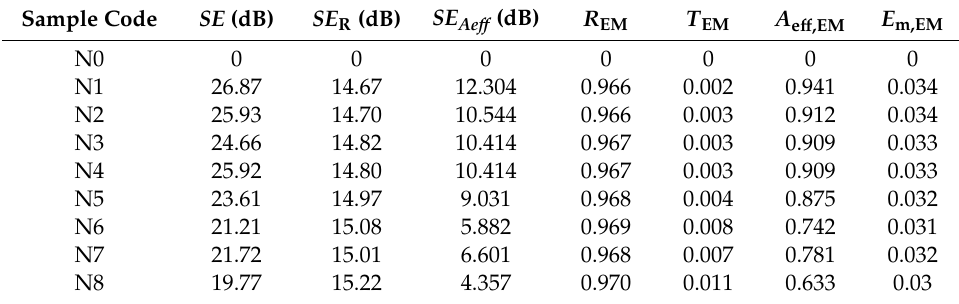
Table 3. Linear relationship between the EMI results and w Ni .